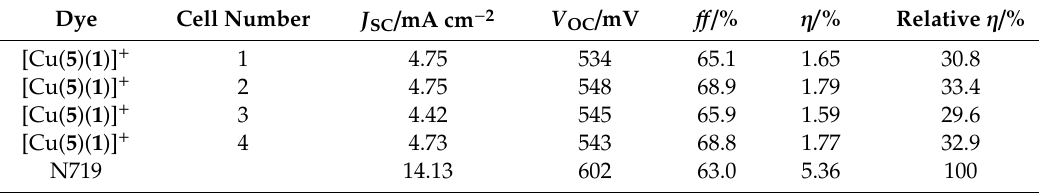
Table 3. Performance parameters (under 1 sun illumination) of duplicate, masked DSCs on the day of sealing the cells the dye [Cu( 5 )( 1 )] + and co-adsorbent DPA. The data are compared to a DSC containing N719 and relative η values are with respect to N719 set at 100%.